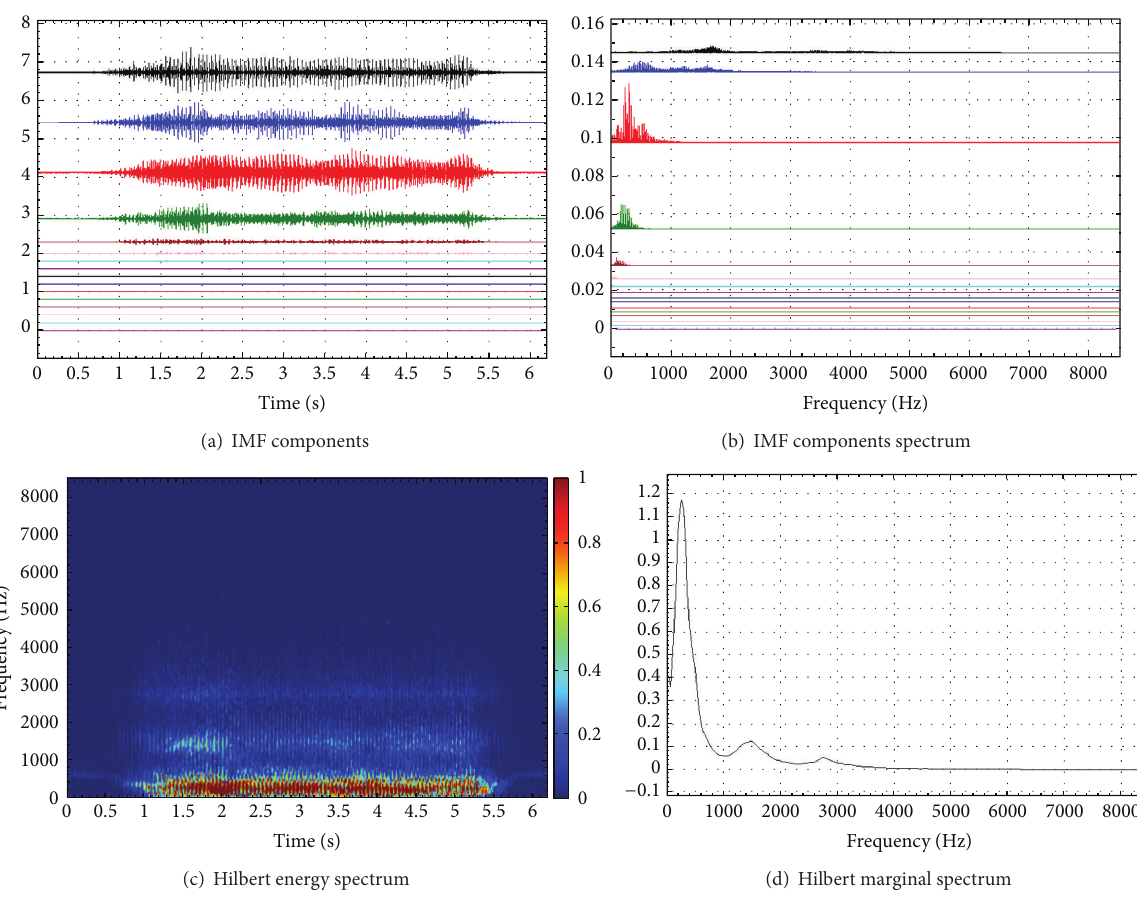
Figure 34: HHT analysis results in working condition